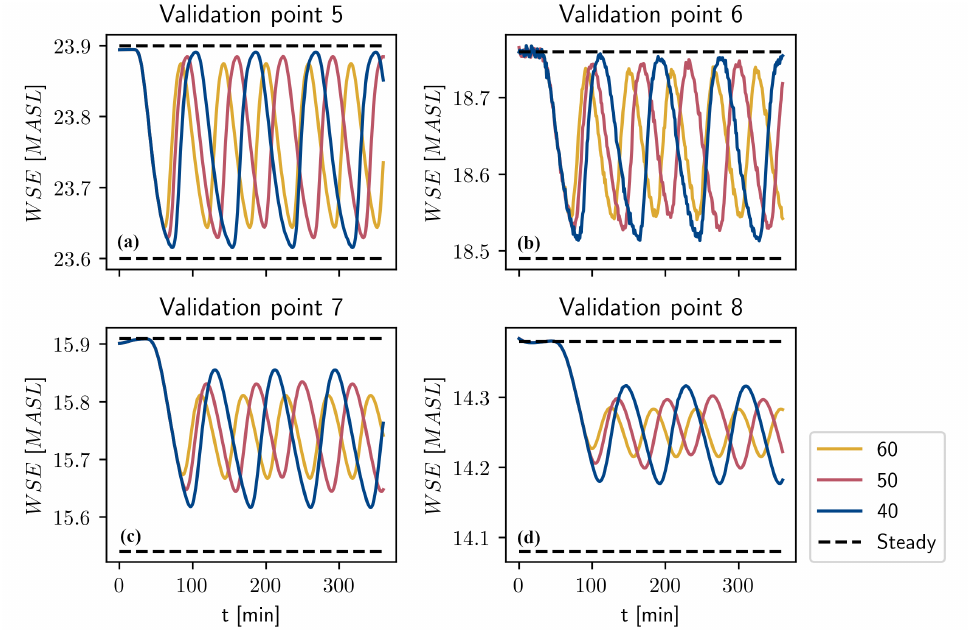
Figure 10. WSE for the points 5, 6, 7, and 8 given the flow scenarios with 40, 50, and 60 flow changes